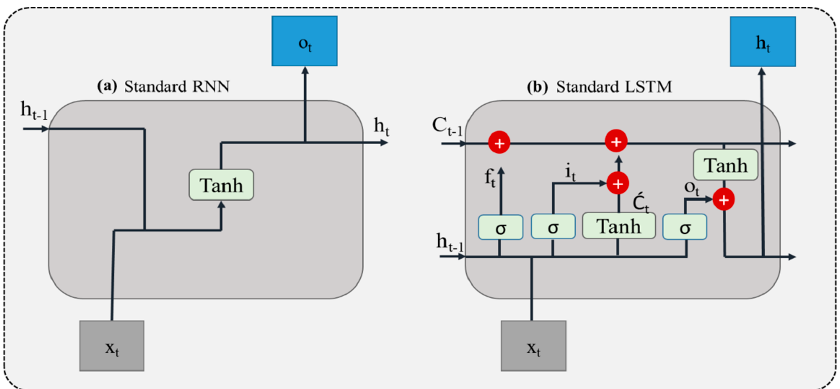
Figure 4. ( a ) Represents the standard RNN unit, ( b ) represents the standard LSTM unit.